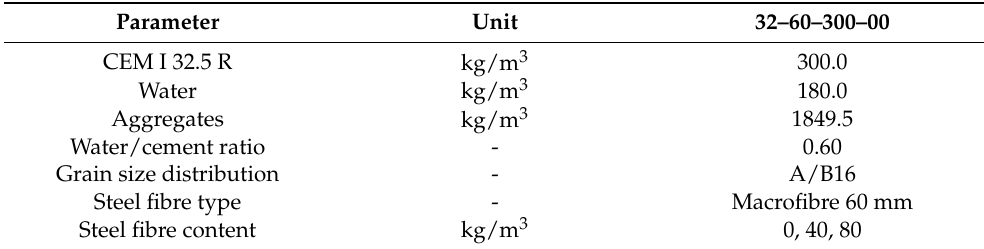
Table 1. Concrete mix design of the basic concrete. Parameter